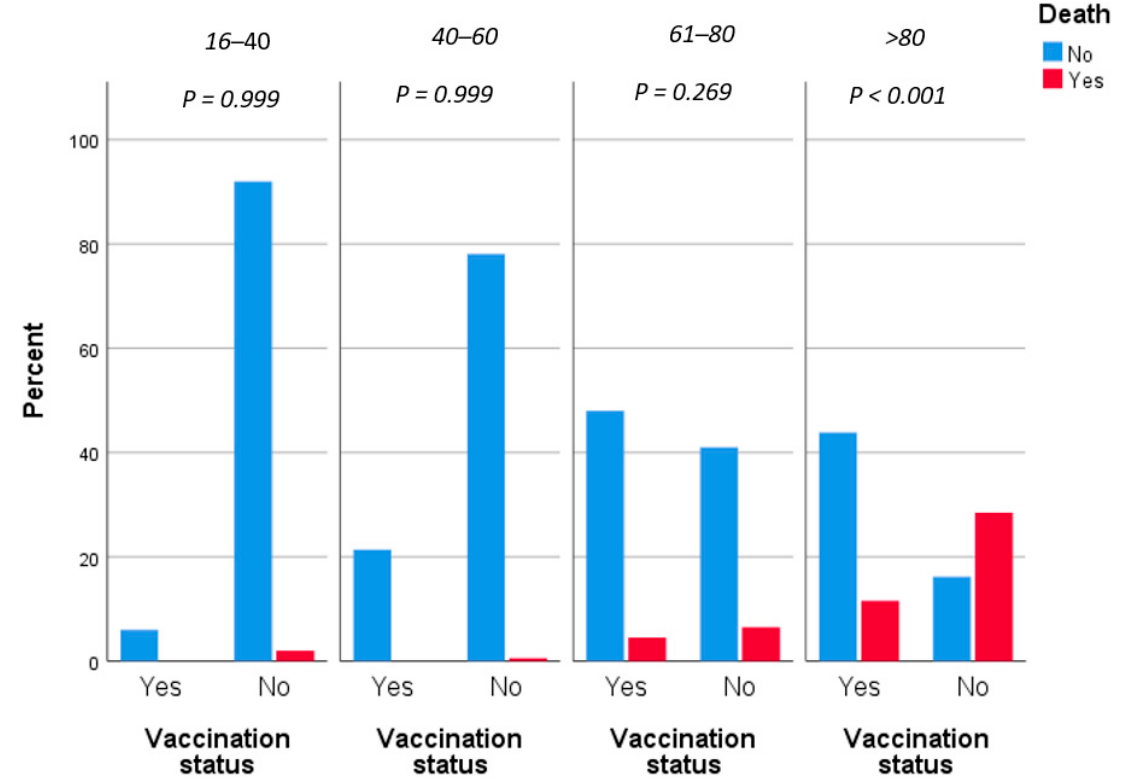
Figure 1. Fatality rates grouped by vaccination status and adjusted by